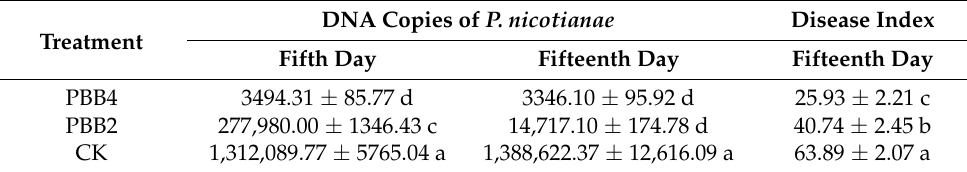
Table 2. The effect of PBB treatment on P. nicotianae population and disease severity. DNA Copies of P. Treatment